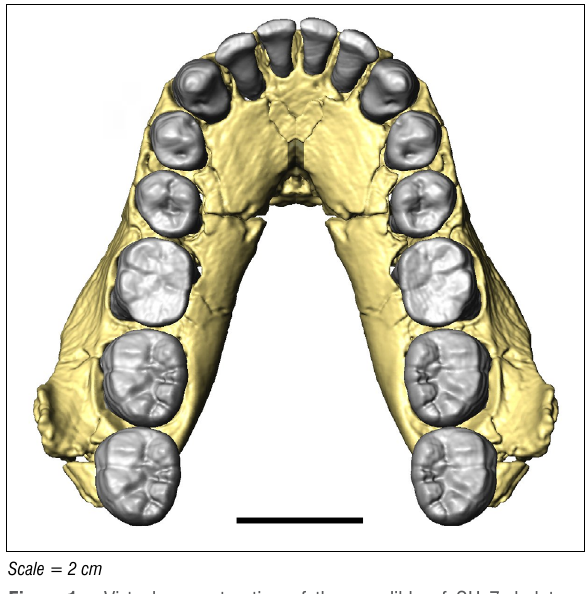
Figure 1: Virtual reconstruction of the mandible of OH 7, holotype of Homo habilis . Reconstruction from Spoor et al. 8 with permission. Table 1: Specimen numbers, taxonomic nomenclature, approximate date, skeletal element (mandible or cranium) and Z-score